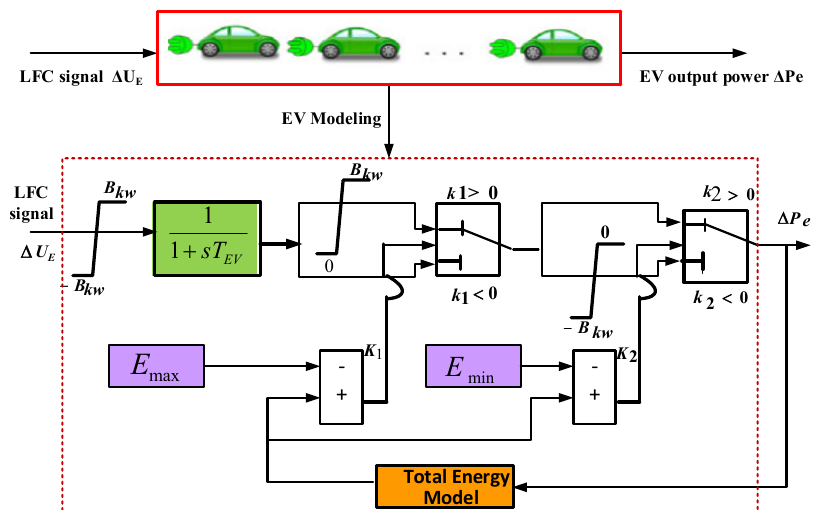
Figure 3. EV Modelling.